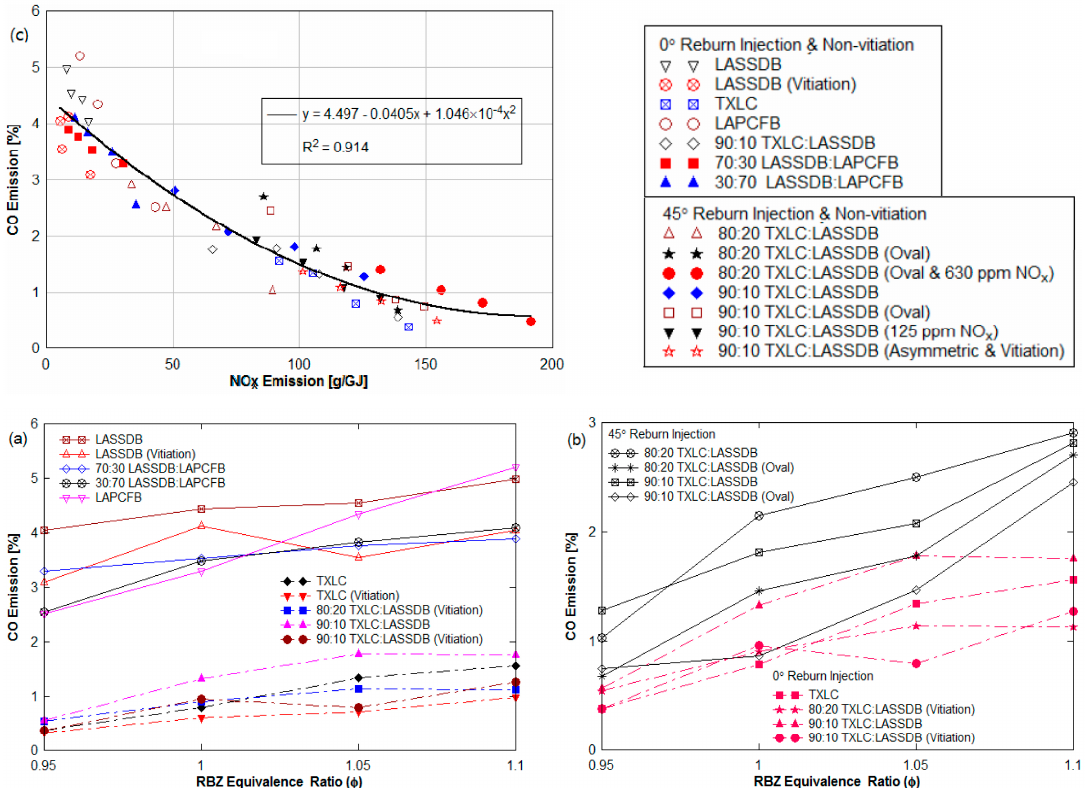
Figure 13. CO emissions: ( a ) Effect of the reburn fuels, ( b ) Effect of the reburn injection, and ( c ) Variation of CO with NO x emissions. Polynomial fit is also presented within figure. y = CO %, x= NO x in